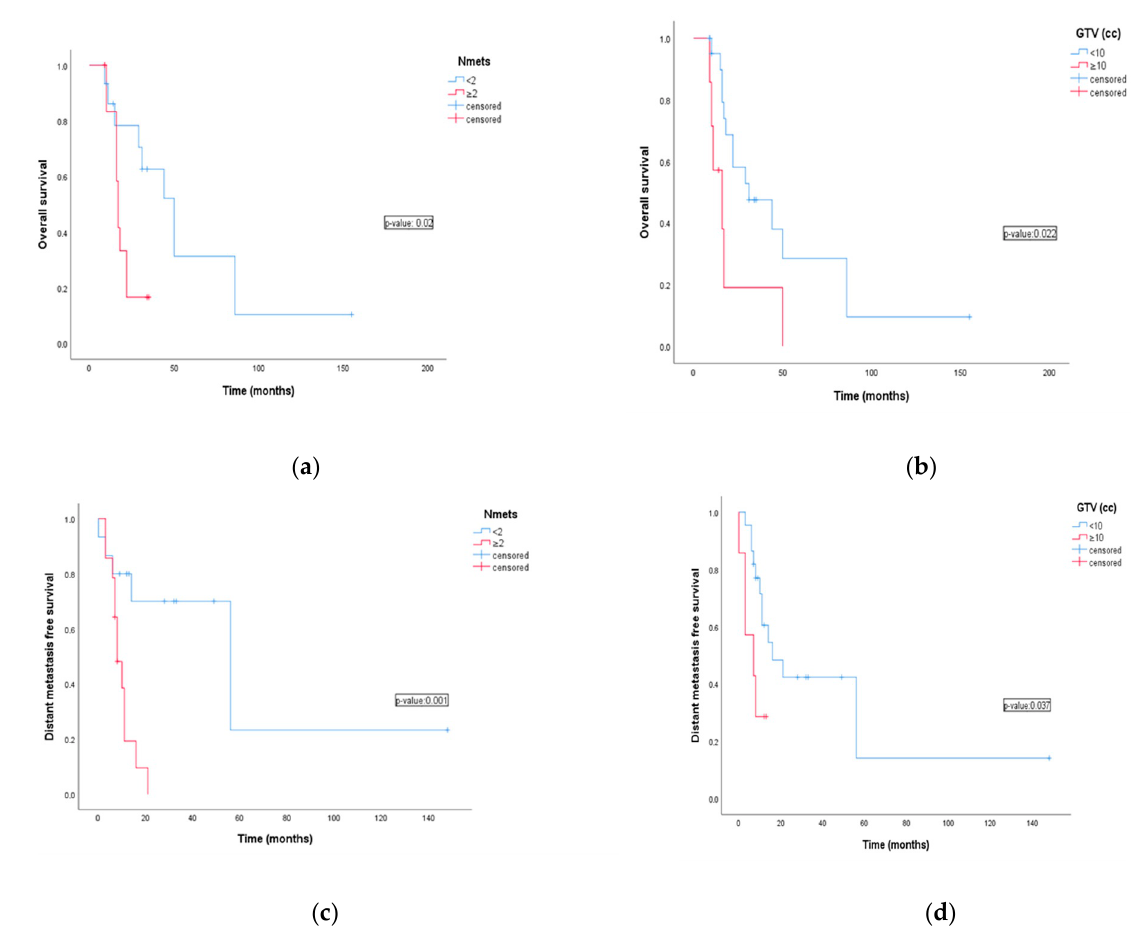
Figure 2. The effects of the potential prognostic factors on survival as analyzed by univariate analysis using log-rank test. ( a ) Overall survival for number of lymph nodes; ( b ) overall survival for Gross Tumor Volume (cc); ( c ) distant metastasis free survival for number of lymph nodes; ( d ) distant metastasis free survival for Gross Tumor Volume (cc).